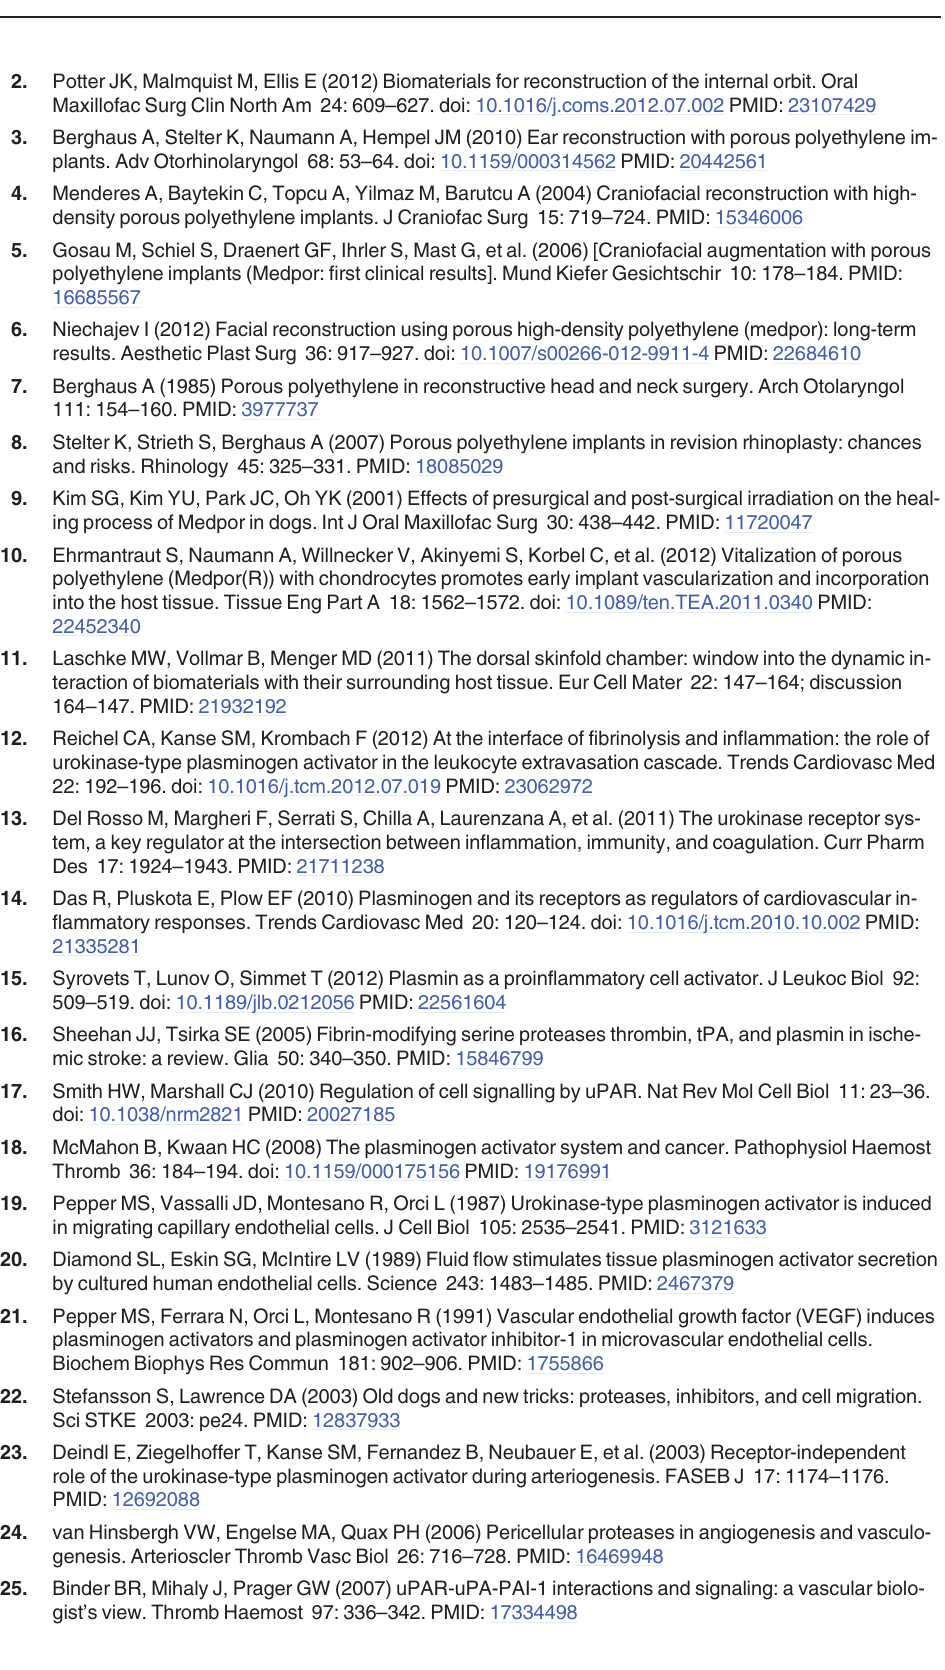
PLOS ONE | DOI:10.1371/journal.pone.0116883 February 6,